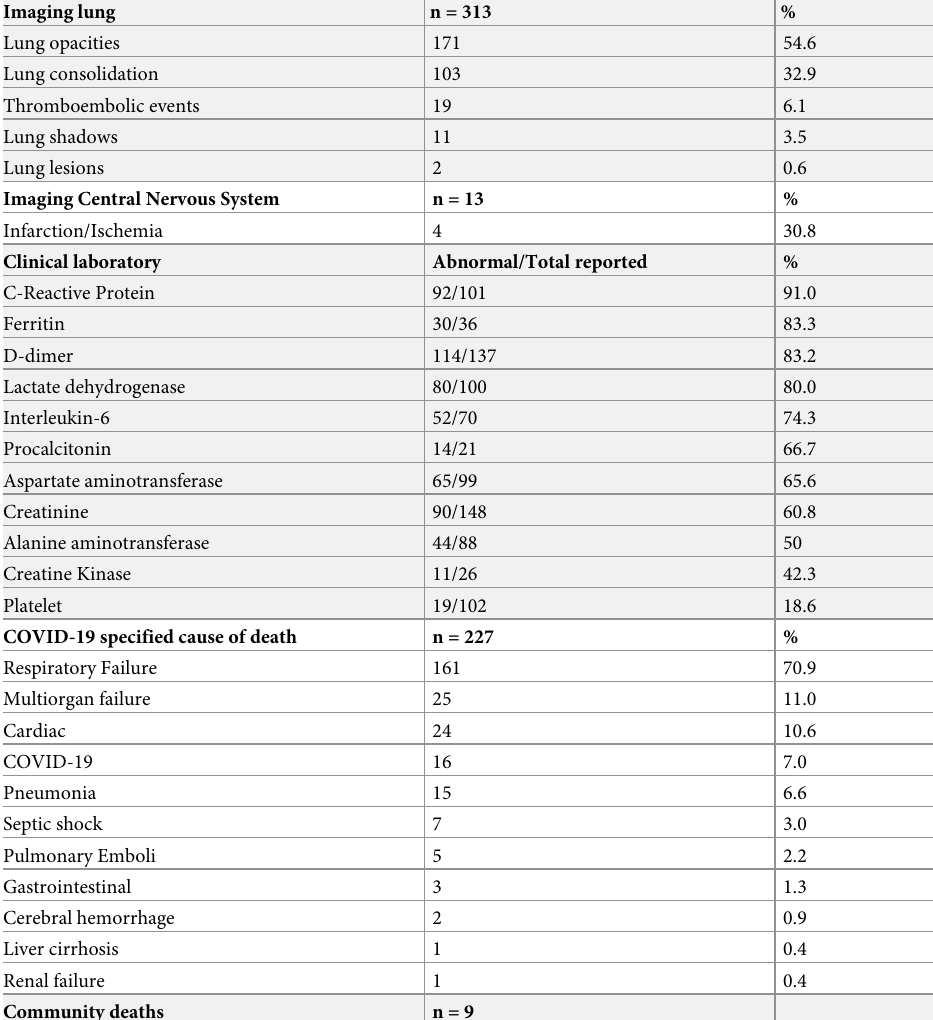
Table 3. Imaging, clinical laboratory and cause of death of COVID-19